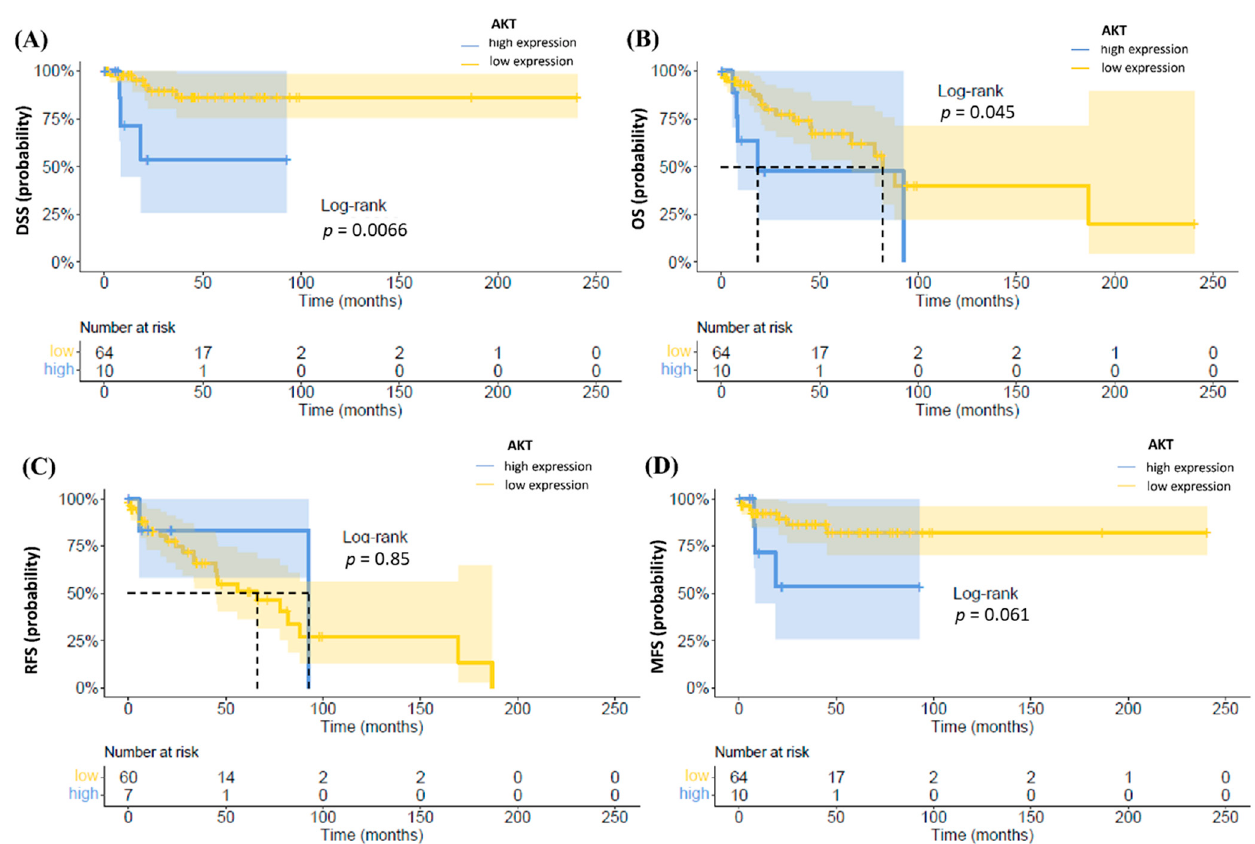
Figure 3. Kaplan–Meier plots of DSS ( A ), OS ( B ), RFS ( C ) and MFS ( D ) according to AKT. High expression of AKT was associated with a worse OS and DSS ( p = 0.045 and p = 0.0066).